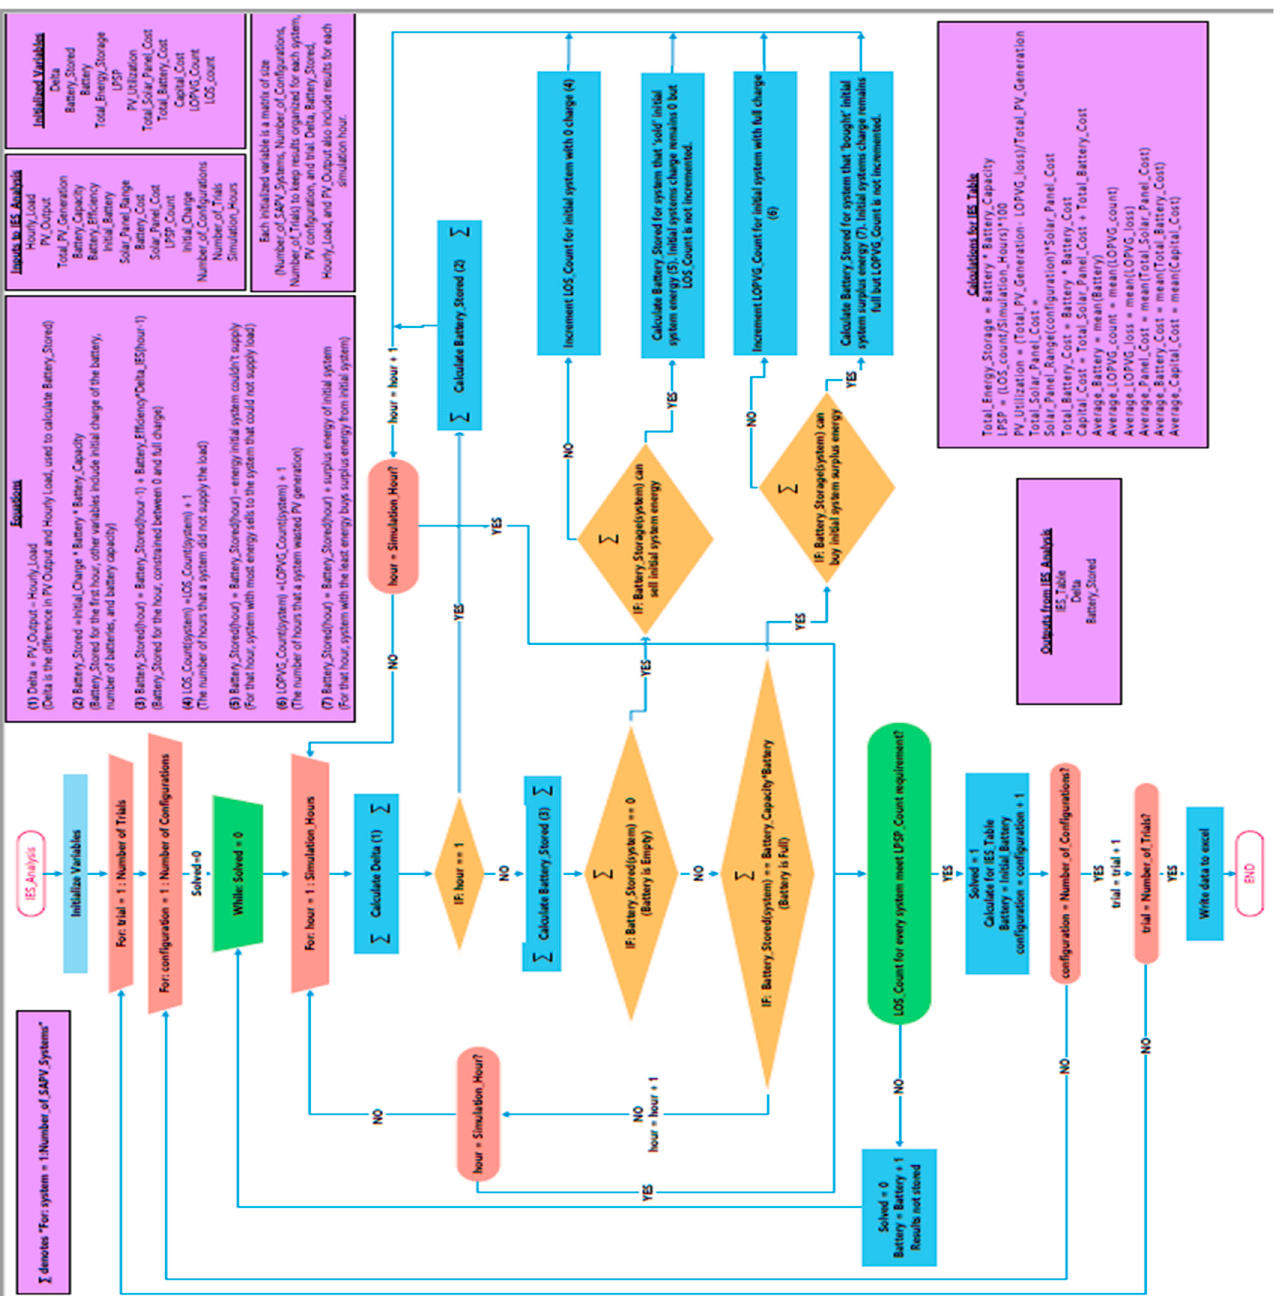
Figure A5. Flow chart describing “IES Analysis.m”. Final output is a table of results with Capital Cost, Total Energy Storage, LPSP, PV Utilization, and Number of Trades.